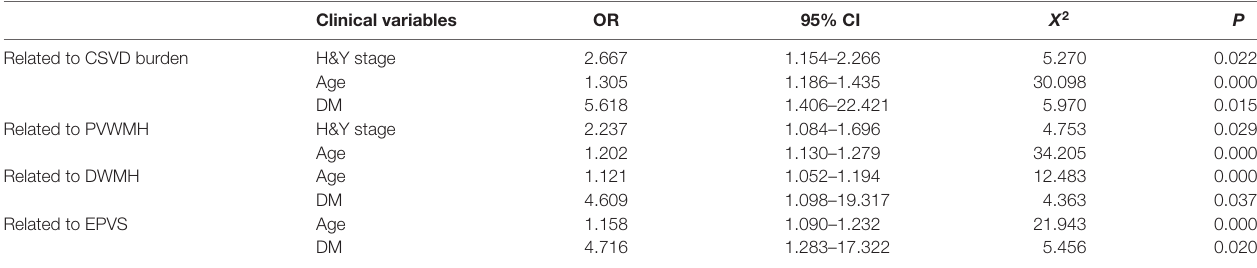
TABLE 3 | Correlation analysis between the CSVD markers clinical variables in PD. Clinical